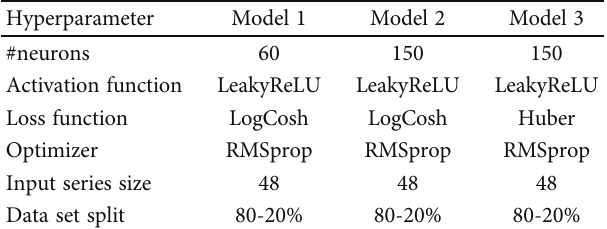
Table 4: Selected models con fi guration.